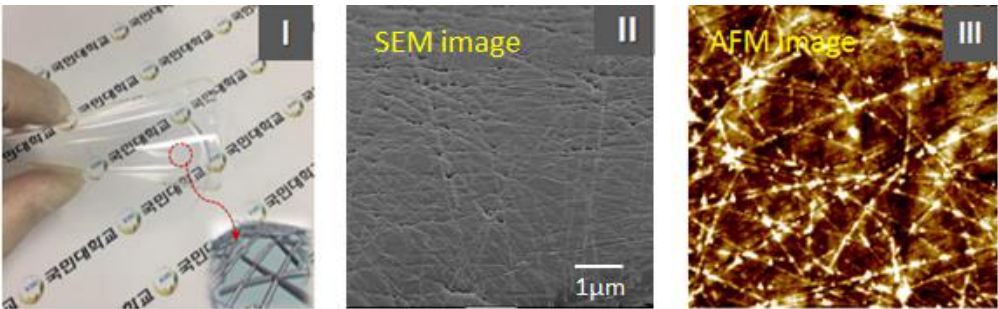
Figure 4. [ I ] Photograph of a STEF sample and [ II ] surface SEM image and [ III ] AFM current image of the Ag NW network-embedded PDMS.